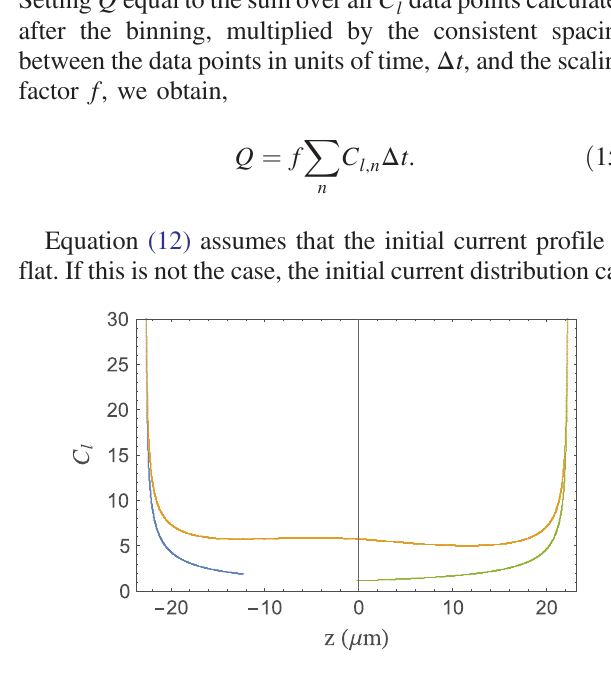
FIG. 11. The local compression ratio mapped to the final longitudinal position values, z . The three colors shown distin- guish the electrons from each of the 3 sections of the bunch visible in Fig. 3 — the core of the bunch and the two edges which fold around on themselves in longitudinal phase